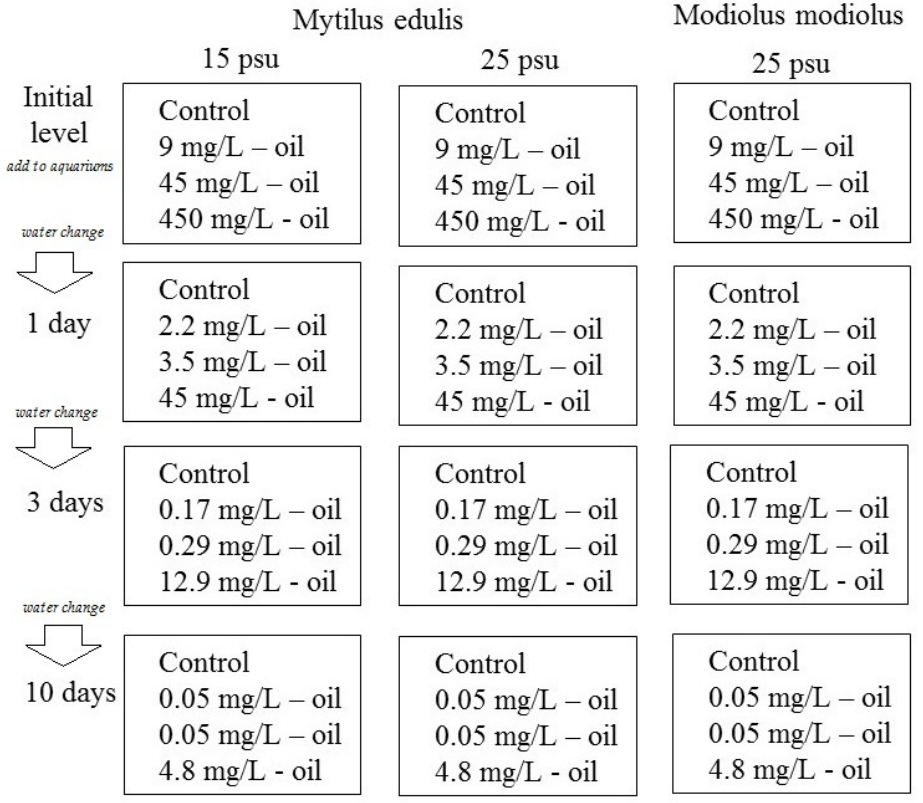
Figure 1. A scheme of the experimental design. Table 1. Nominal and measured total hydrocarbon content (THC, mg/L) in treatment waters at exposure start (initial) and following 1, 2, 3, and 10 days of exposure to low, medium, and high crude oil treatments. Values are mean ± standard error ( n =